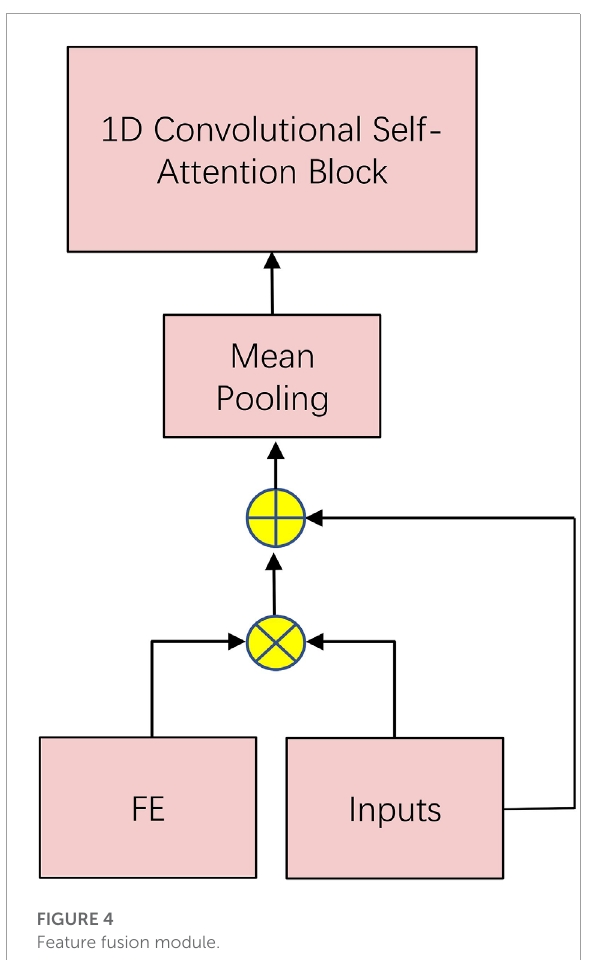
FIGURE 4 Feature fusion module.